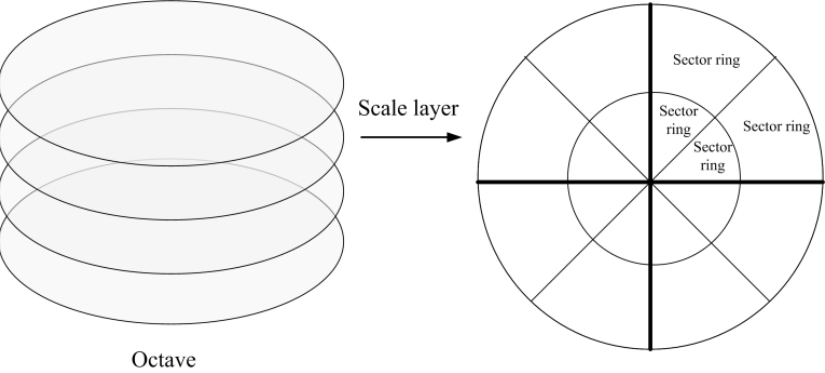
Figure 1. The octave and division of the scale layer. The left side shows the octave consisting of scale layers. The right side shows the scale layer consisting of 16 sector